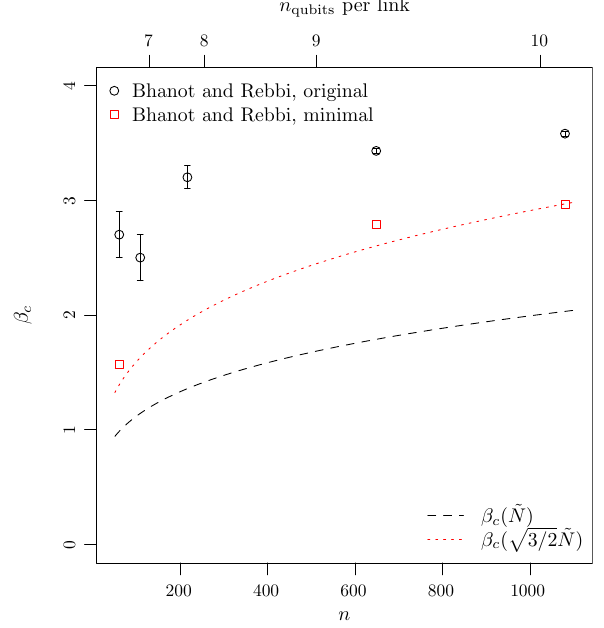
Fig. 6 The critical value β c in SU ( 3 ) as a function of the number n of elementsintheset.ThelinesrepresenttheapproximationEq.(30)where the order ˜ N ( n ) is obtained from Eq. (34) and Eq. (33). The reference data by Bhanot and Rebbi [30] comes from their Table 1 (“original”) and from the leftmost points of the hysteresis loops in their Figures 1–3 (“minimal”),